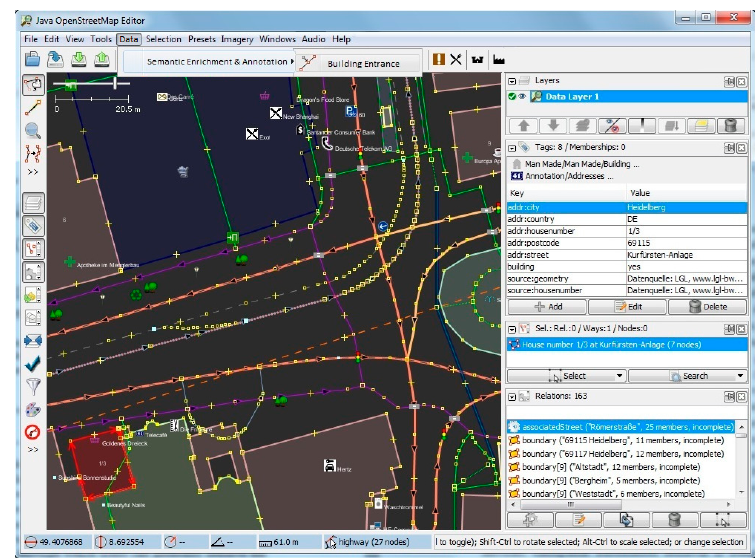
Figure 8. Relational properties of a sample random building.